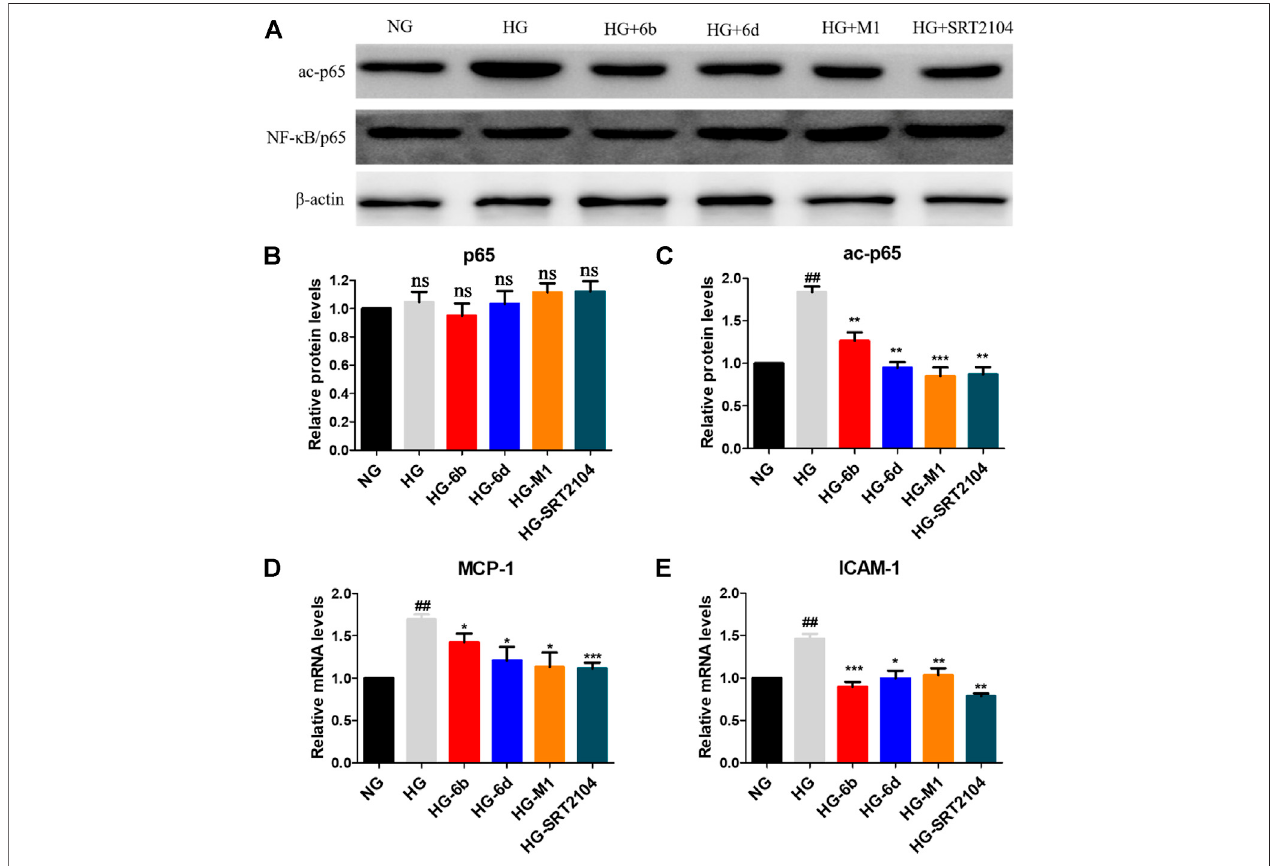
FIGURE 8 | (A – C) Effects of the target compounds on protein expression levels of p65 and ac-p65 in HG stimulating HK-2 cells via Western blotting. Cells were treated with the target compounds with dose of 10 μ M for 48 h. (D – E) Expression of mRNA levels of MCP-1 and ICAM-1 in HG-inducted HK-2 cells when treated with the target molecules (10 μ M) for 48 h. # HG compared with NG control group, *Dosing group compared to HG group, */ # p < 0.05, **/ ## p < 0.01, *** p < 0.001, ns means not signi fi cant.